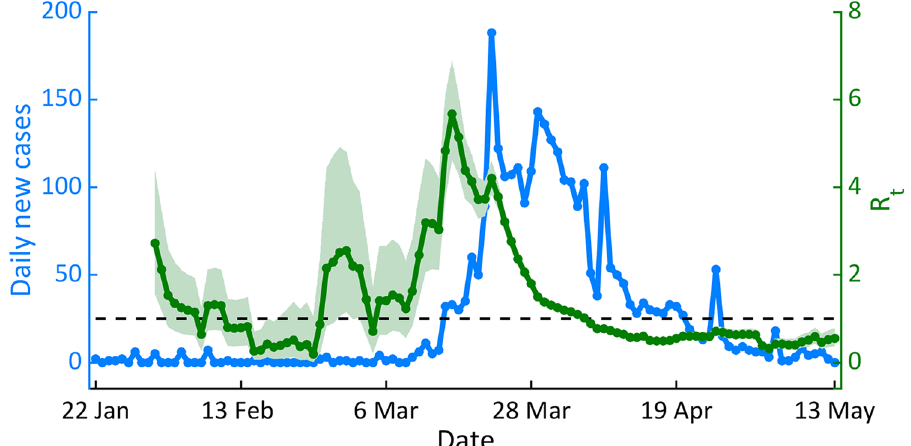
Figure 2. The time-varying reproduction numbers during the first epidemic wave. The solid green line shows the median of R t and the green shaded area indicates the 95% confidence interval (CI). The horizontal dashed black line indicates the R t threshold value of 1. The solid blue line indicates the number of daily new COVID-19